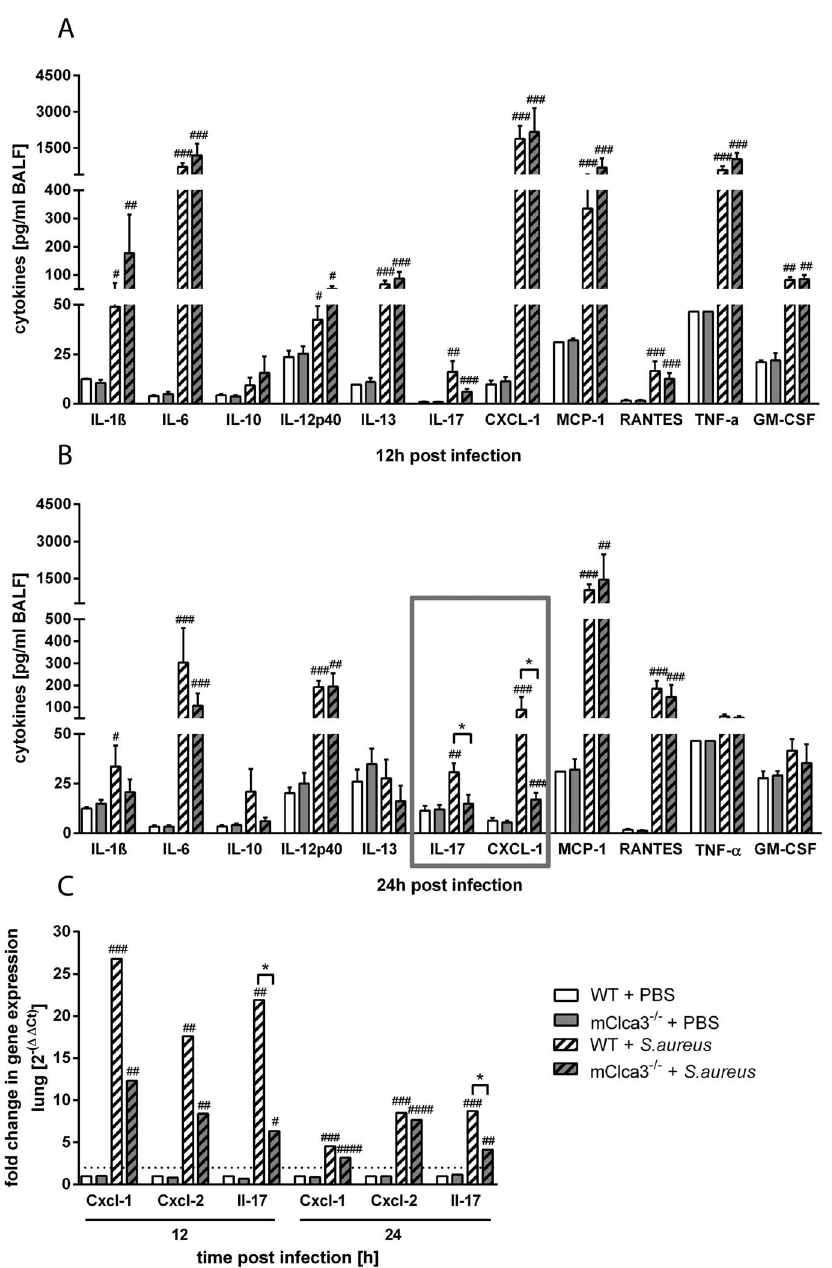
Figure 2. Chemokine CXCL-1 and cytokine IL-17 were significantly decreased in BALF of infected mCLCA3-deficient mice. (A, B) Protein levels of cytokines were measured at 12 hours and 24 hours post infection by multiplex assay technique (IL-1 b , IL-6, IL-10, IL-12p40, IL-13, CXCL-1, MCP-1, RANTES, TNF- a , GM-CSF) or by ELISA (IL-17) in BALF. (C) Expression levels of Cxcl-1, Cxcl-2 and Il-17 were quantified by RTq-PCR in the lungs. Dotted line indicates a fold change of 2 as limit for valid statement of elevated parameters. Values are given as mean 6 SEM (n=6 to 8